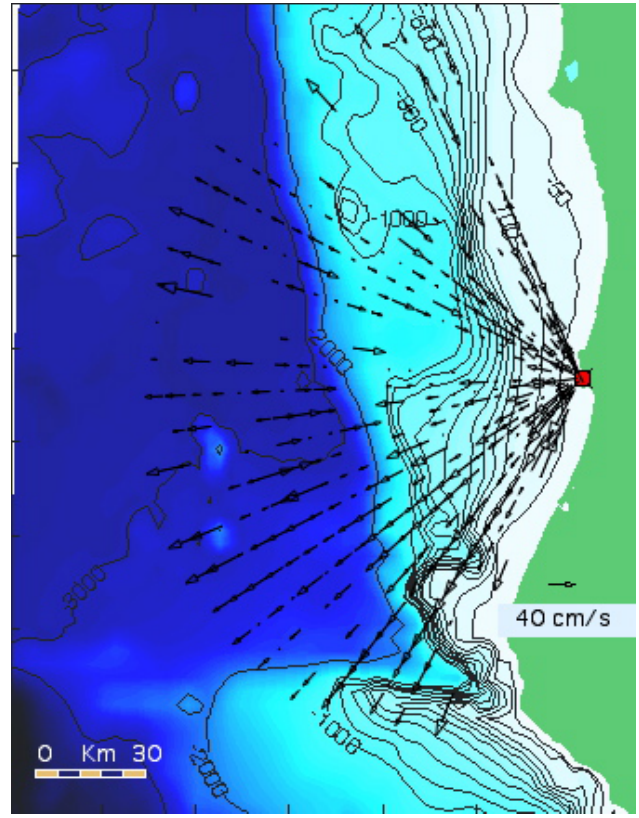
Figure 7. The location of the radar at Trinidad River, California, the offshore bathymetry and a measured radial velocity map. Measured radial velocities are for 11 March 2011, 17:36 UTC, and show the reverse flow generated by the tsunami in the inner range calls.